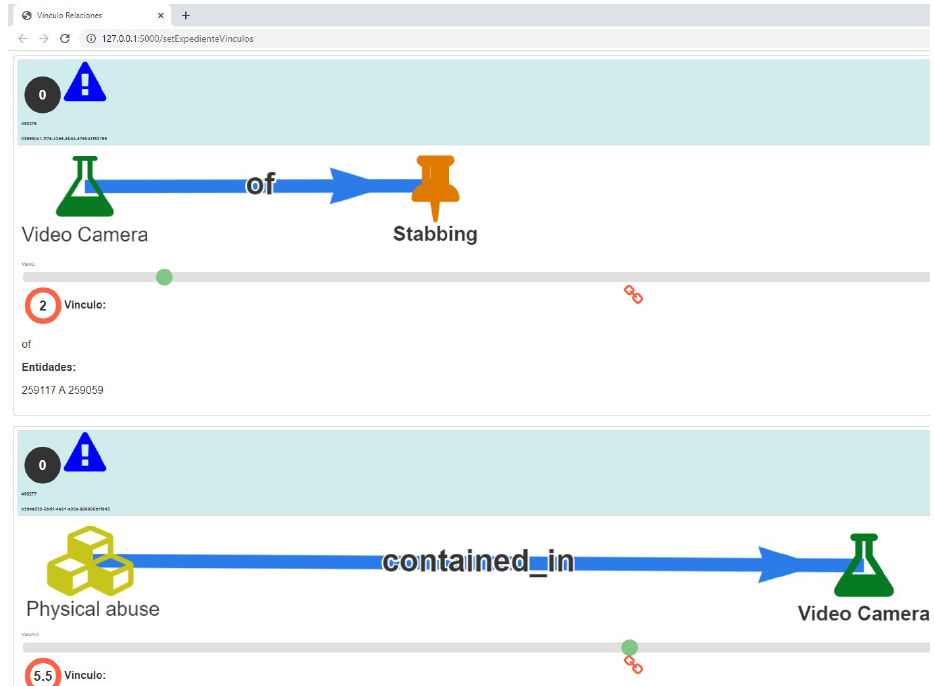
Figure 4. EGI allows the evaluation and listing of links between facts and evidence in a